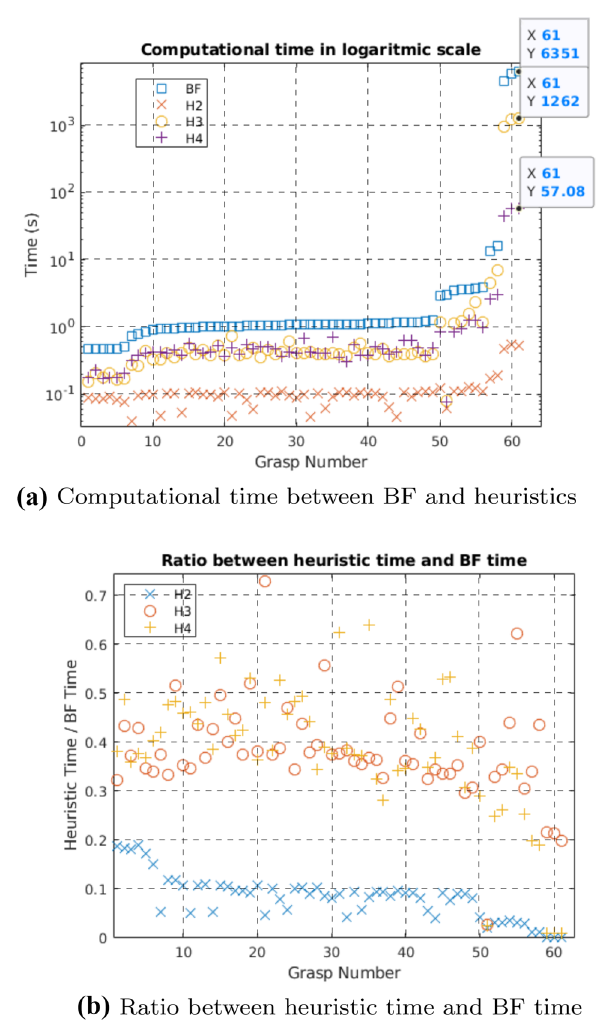
Fig. 6 Computational time of the PGR index for a set of 60 grasps executed on two objects in simulation. Brute Force (BF) corre- sponds to the PGR index for all possible combinations and Heuris- tics H2,H3 and H4 to the reduced set of contact point